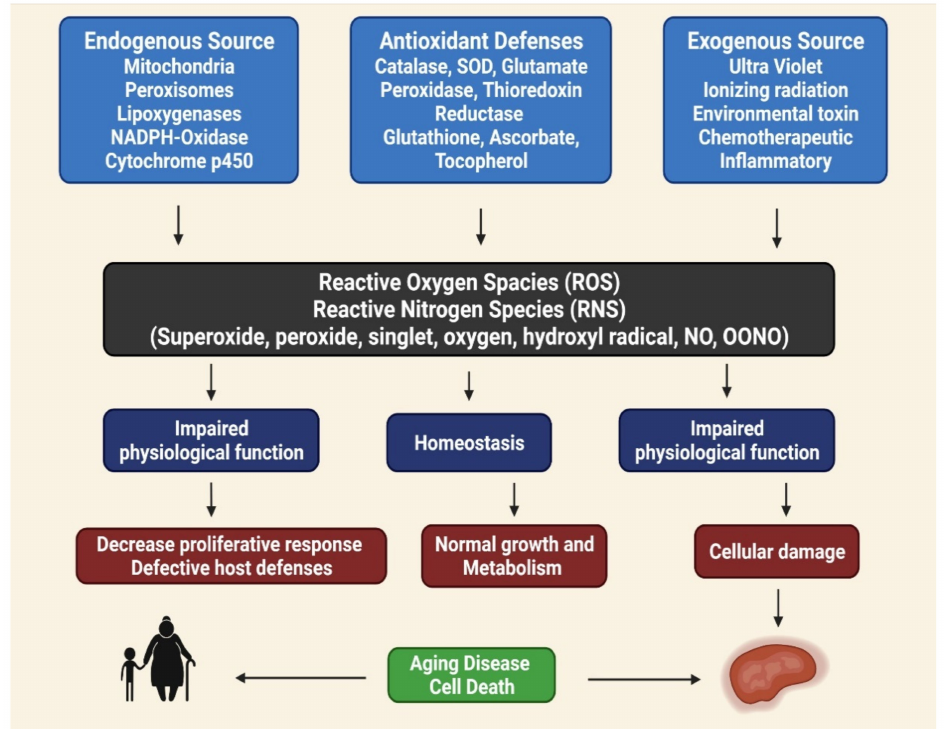
Figure 1. Role of reactive oxygen (ROS) and reactive nitrogen (RNS) species for aging disease and cell death, homeostasis and impaired physiological function